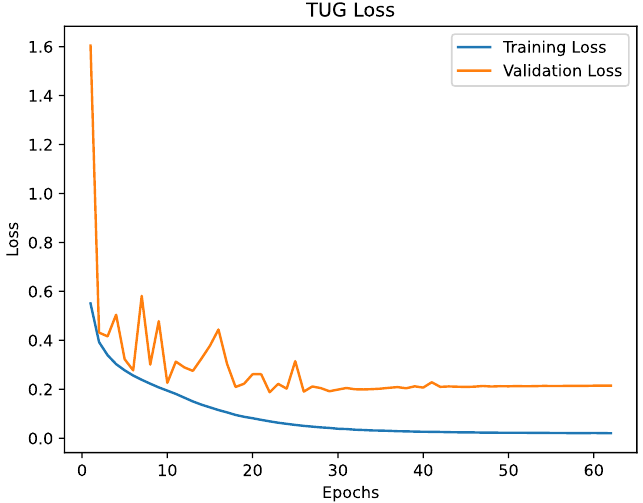
Figure 5. The loss of the TUG model. For the first 25 epochs the loss indicates that the learning rate is Figure 3. The loss of the TUG model. For slightly too large. From epoch 25 the progress shows an asymptotic behaviour. the first 25 epochs the loss indicates that the learning rate is slightly too large. From epoch 25 the progress shows an asymptotic behaviour.